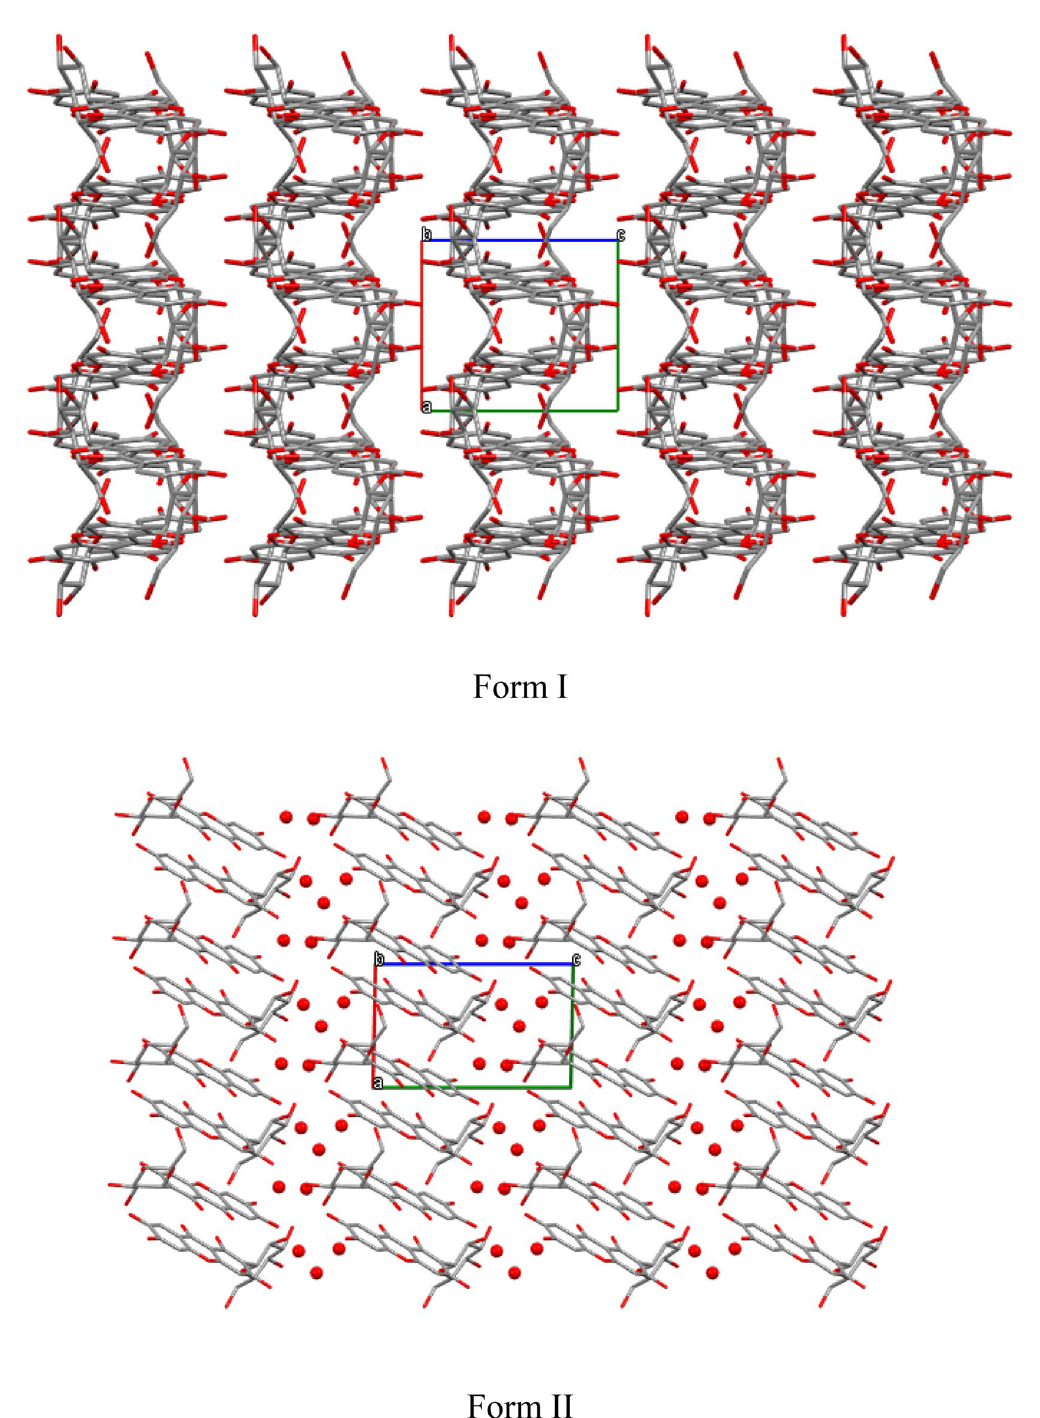
Fig. 5 Molecular packing for polymorphs of Mangiferin viewed down crystallographic b -axis respectively. (Mangiferin molecules are in stick style, crystalline water molcules are in ball